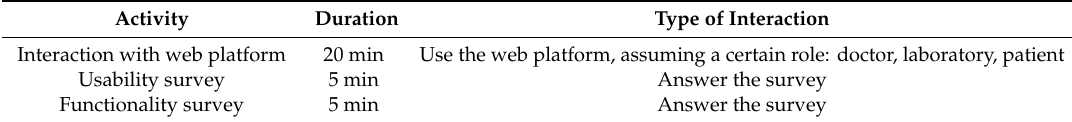
Table A2. Activities performed by surveyed individuals.